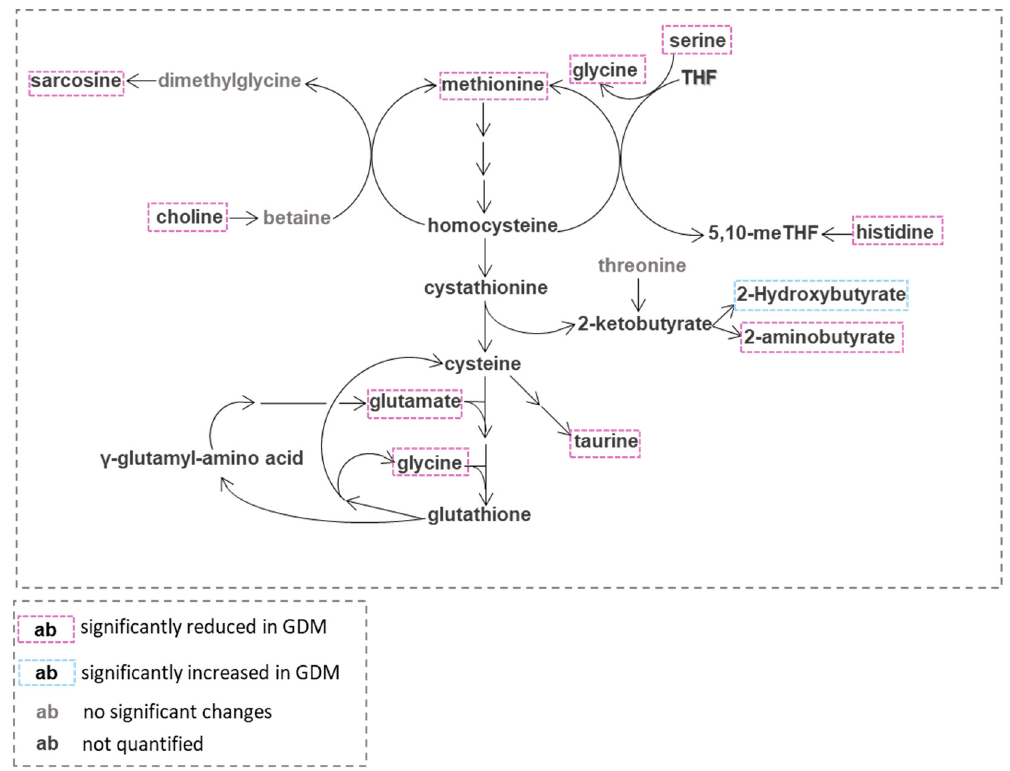
Figure 3. Choline, threonine and one-carbon metabolism; 5,10-meTHF:5 , 10-Methylenetetrahydro-